Question: Write a descriptive caption for this figure.
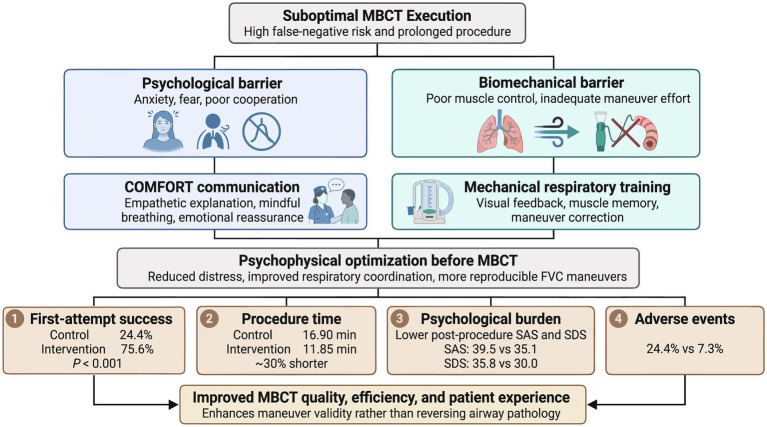
Answer: Mechanistic graphical abstract of COMFORT-based communication and respiratory training before MBCT. Psychological reassurance and respiratory maneuver rehearsal jointly reduce distress and correct suboptimal breathing mechanics before methacholine bronchial challenge testing. These effects improve first-attempt maneuver success, shorten testing time, and reduce mild procedure-related adverse events, while the observed spirometric gains reflect improved effort and maneuver quality rather than immediate physiological reversal of airway dysfunction.